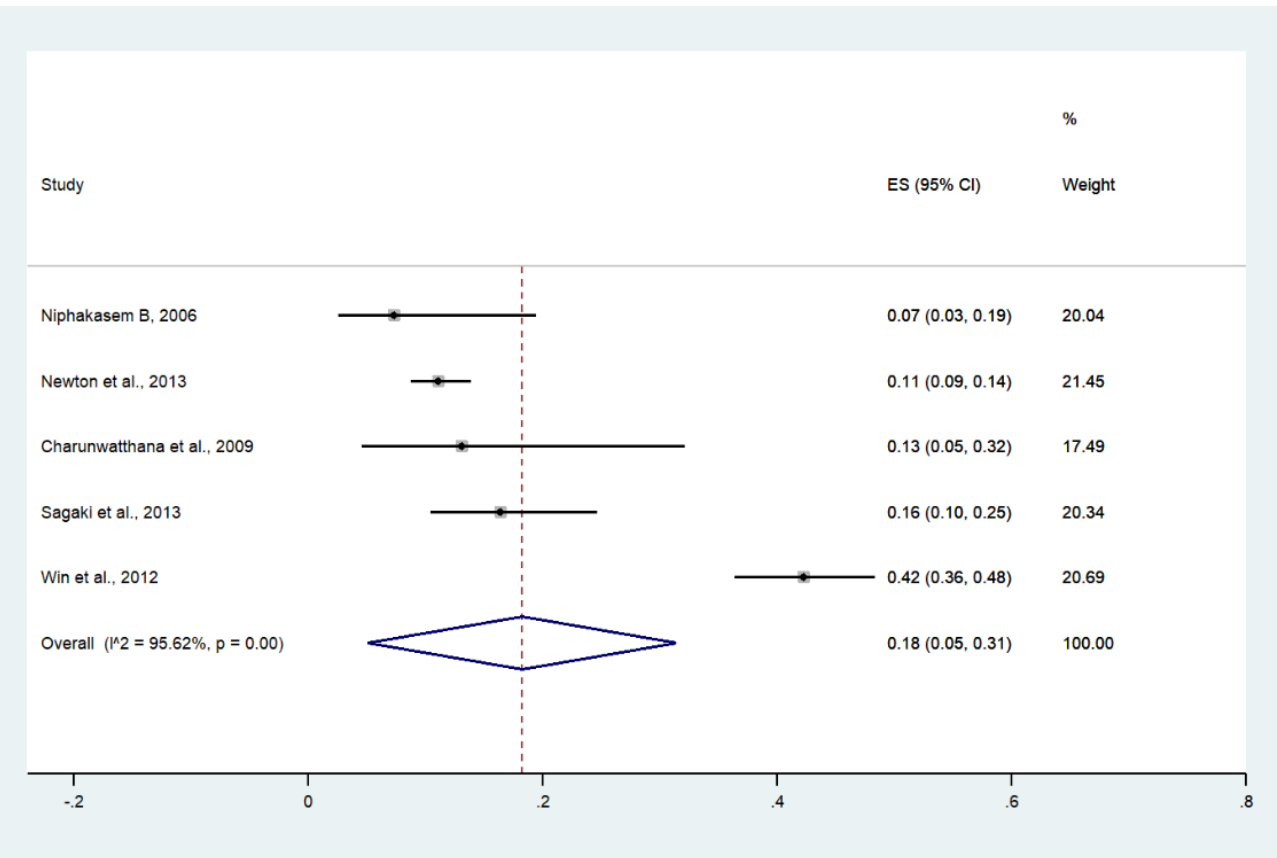
Figure 8. The pooled prevalence of acidosis among patients with severe malaria in Thailand . The label for the x-axis is the scale of estimated prevalence. Abbreviations; ES, estimated prevalence; CI, confidence interval .